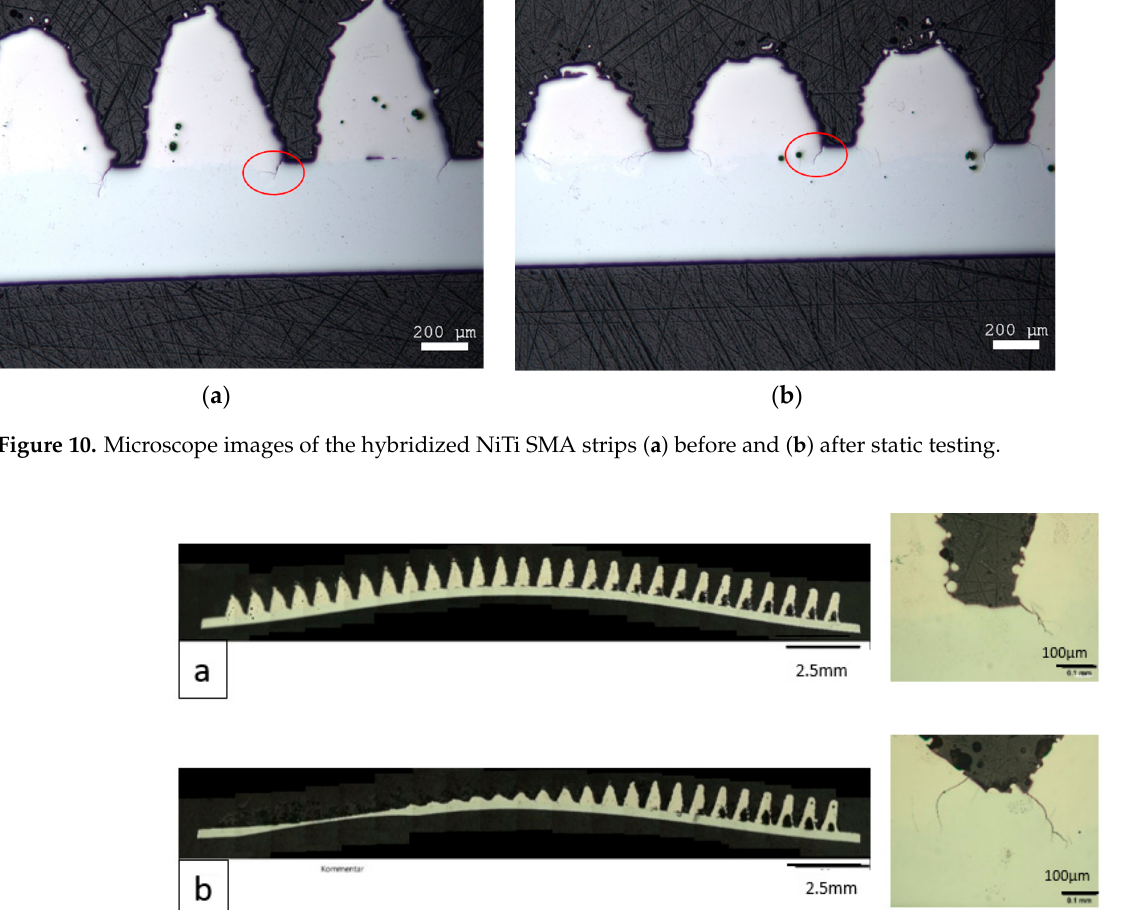
Figure 11. Microscope images of the hybridized NiTi SMA strips before and after dynamic testing: ( a ) Before: overview image (left); detailed image (right); ( b ) After: overview image (left); detailed image (right). load; see Figure 12.